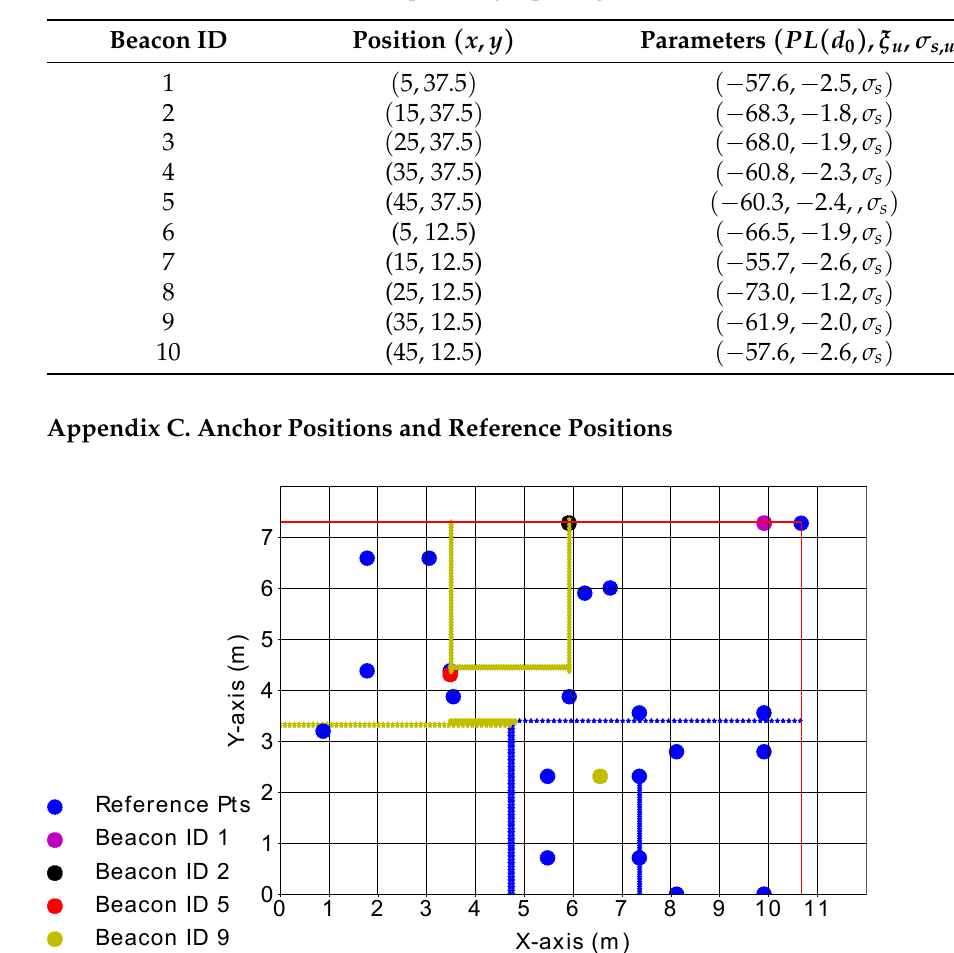
Table A2. Anchor characteristics for proximity reporting.